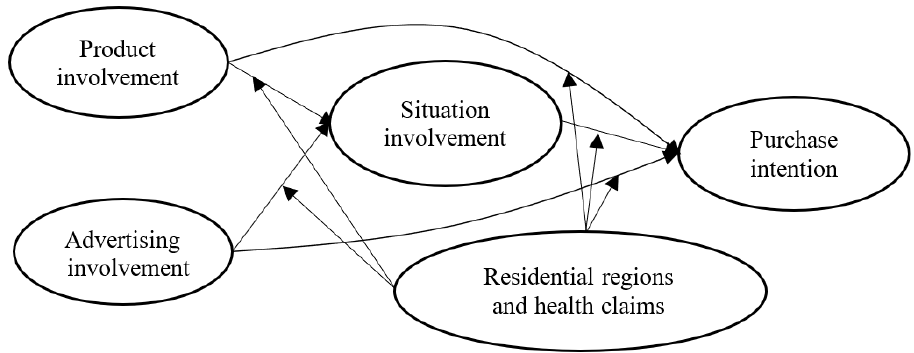
Figure 1. Conceptual model of the relationships between involvement types and purchase